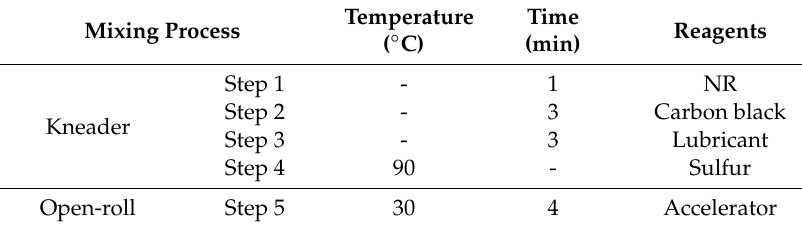
Table 2. Mixing conditions for the NR